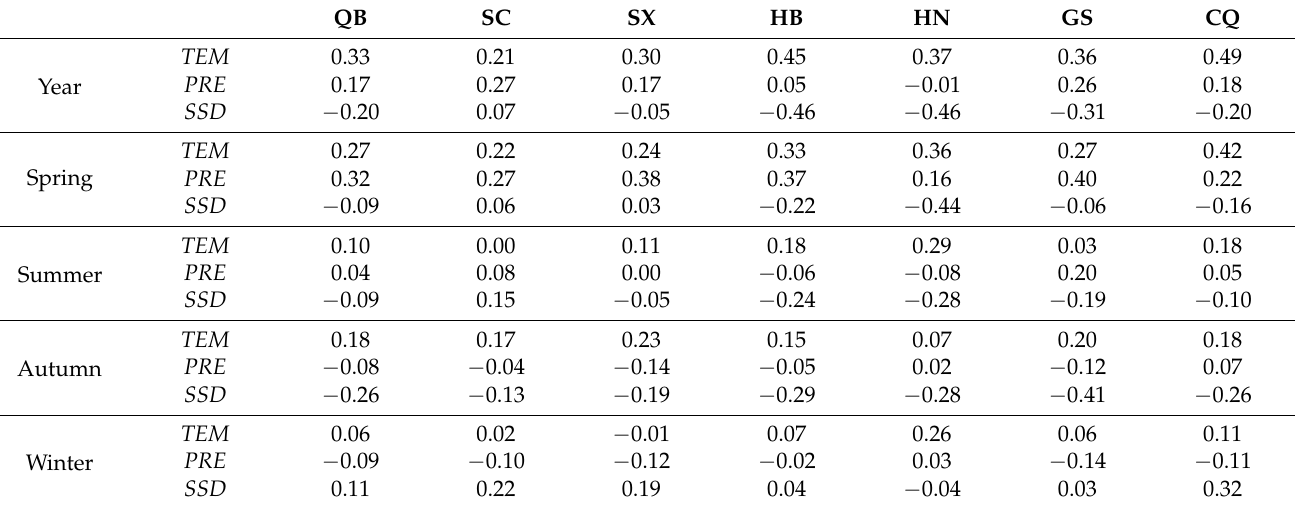
Figure 15. Spatial distribution of the correlation between seasonal FVC and SSD in the QBM from 2000–2020. Table 14. Relative importance index of climate factors in the Table 13. Area proportion of correlation level between FVC and SSD/%.